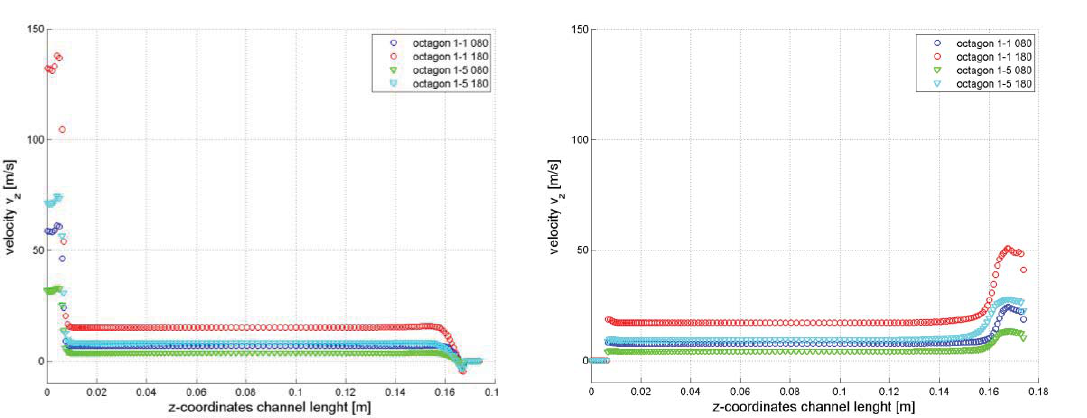
in an open and closed channel Z